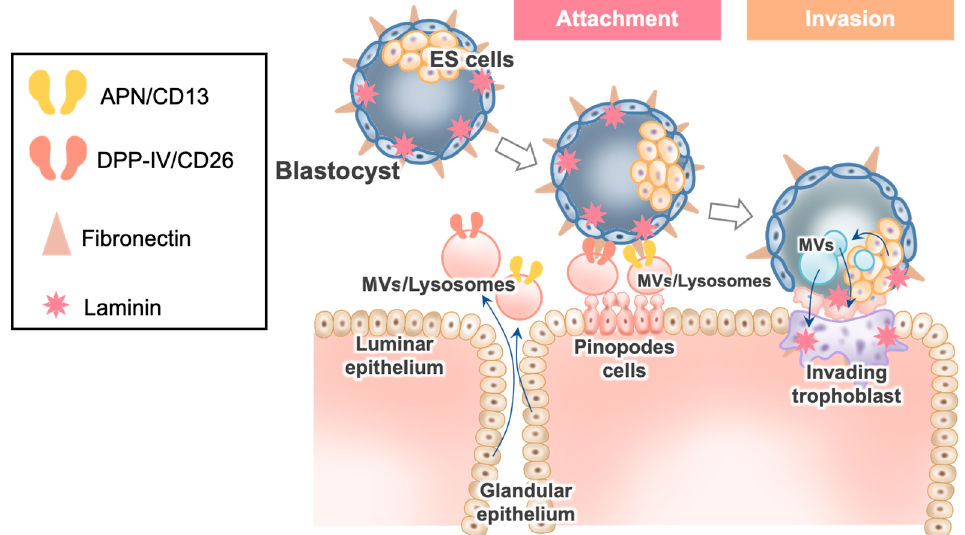
Figure 1. Hypothetical scheme for the possible involvement of APN/CD13 and DPPIV/CD26 expressed in MVs/lysosomes in blastocyte adhesion to EECs.